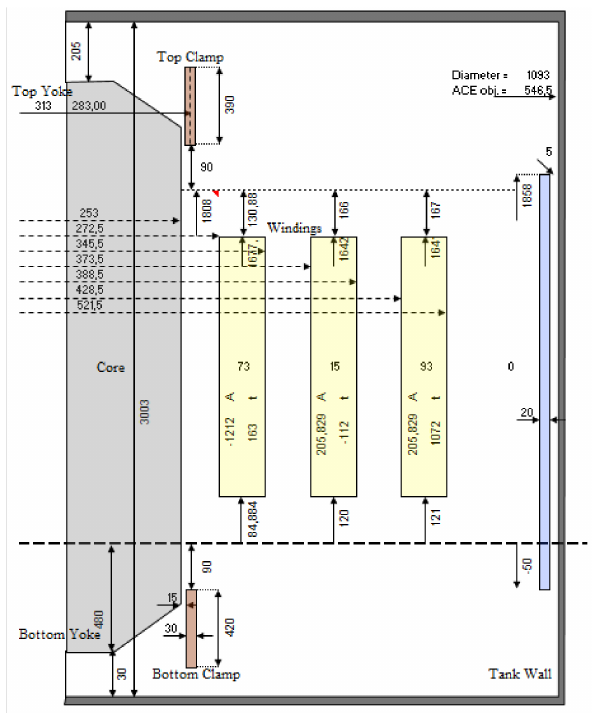
Figure 2. Developed 2D FEM model: 40 MVA 88/11